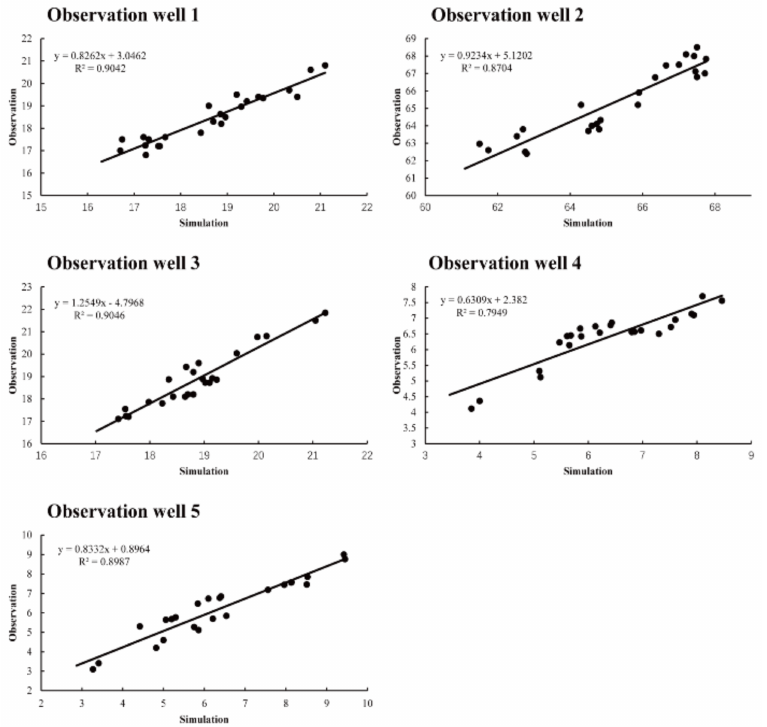
Figure 7. Observation wells 1–5, scatter plots of groundwater level of observed and simulated values in the study area.